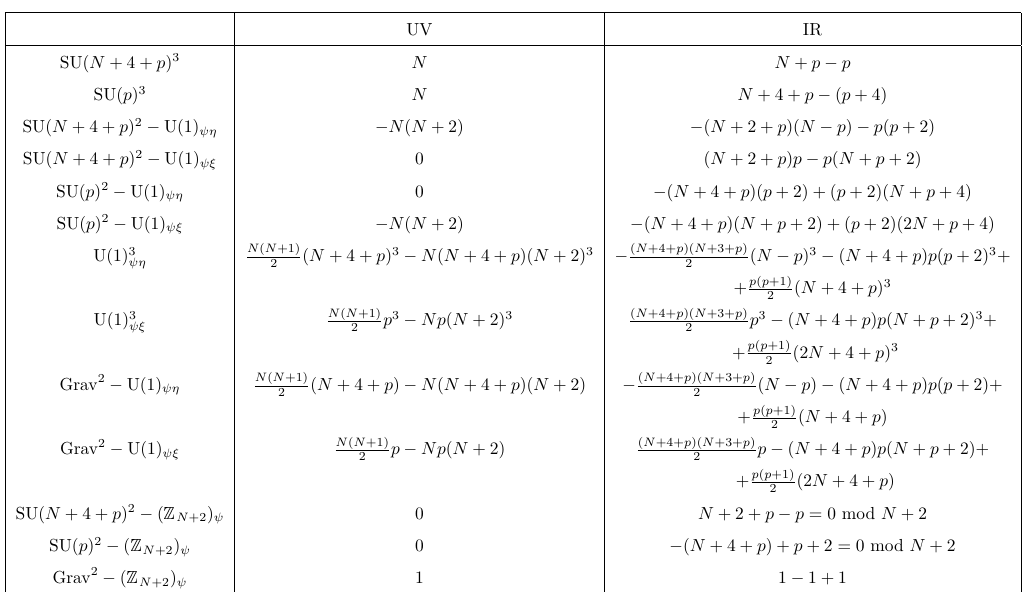
Table 6 . Chirally symmetric phase of the BY model.